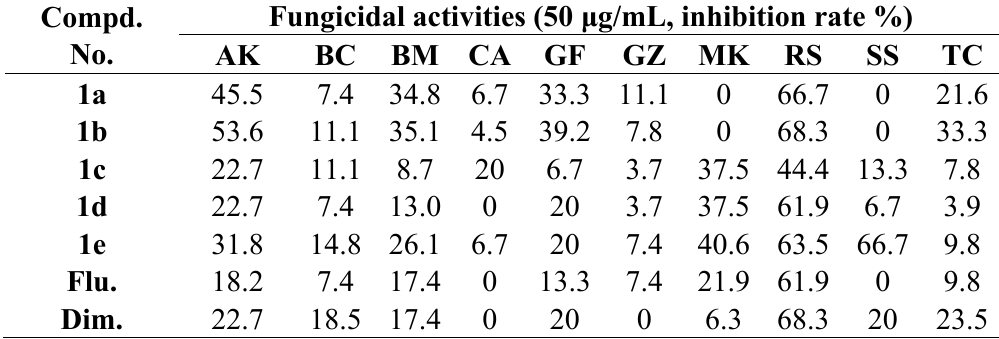
Table 1. The antifungal activity of the synthesized compounds 1